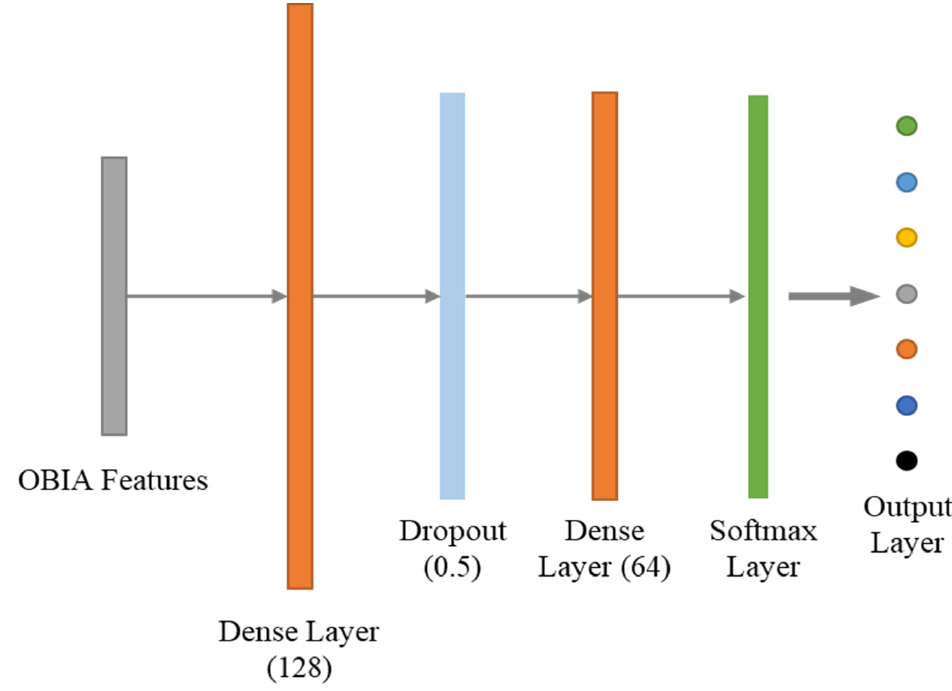
Figure 5. ANN architecture used in integrated OBIA-deep learning frameworks.